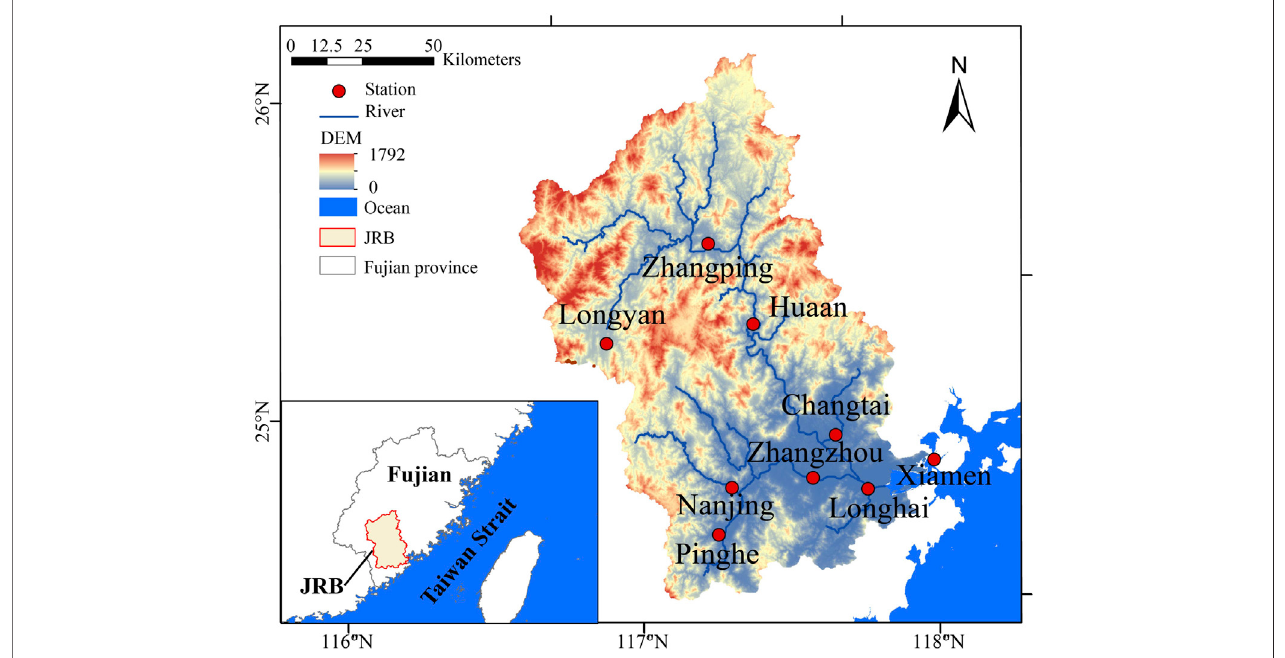
FIGURE1| ThelocationandtopographyofJRBandthedistributionofraingaugingstations.TheelevationsarecoloredbasedonaDigitalElevationModel.Thered and grey line indicate the boundary of JRB and Fujian province respectively.